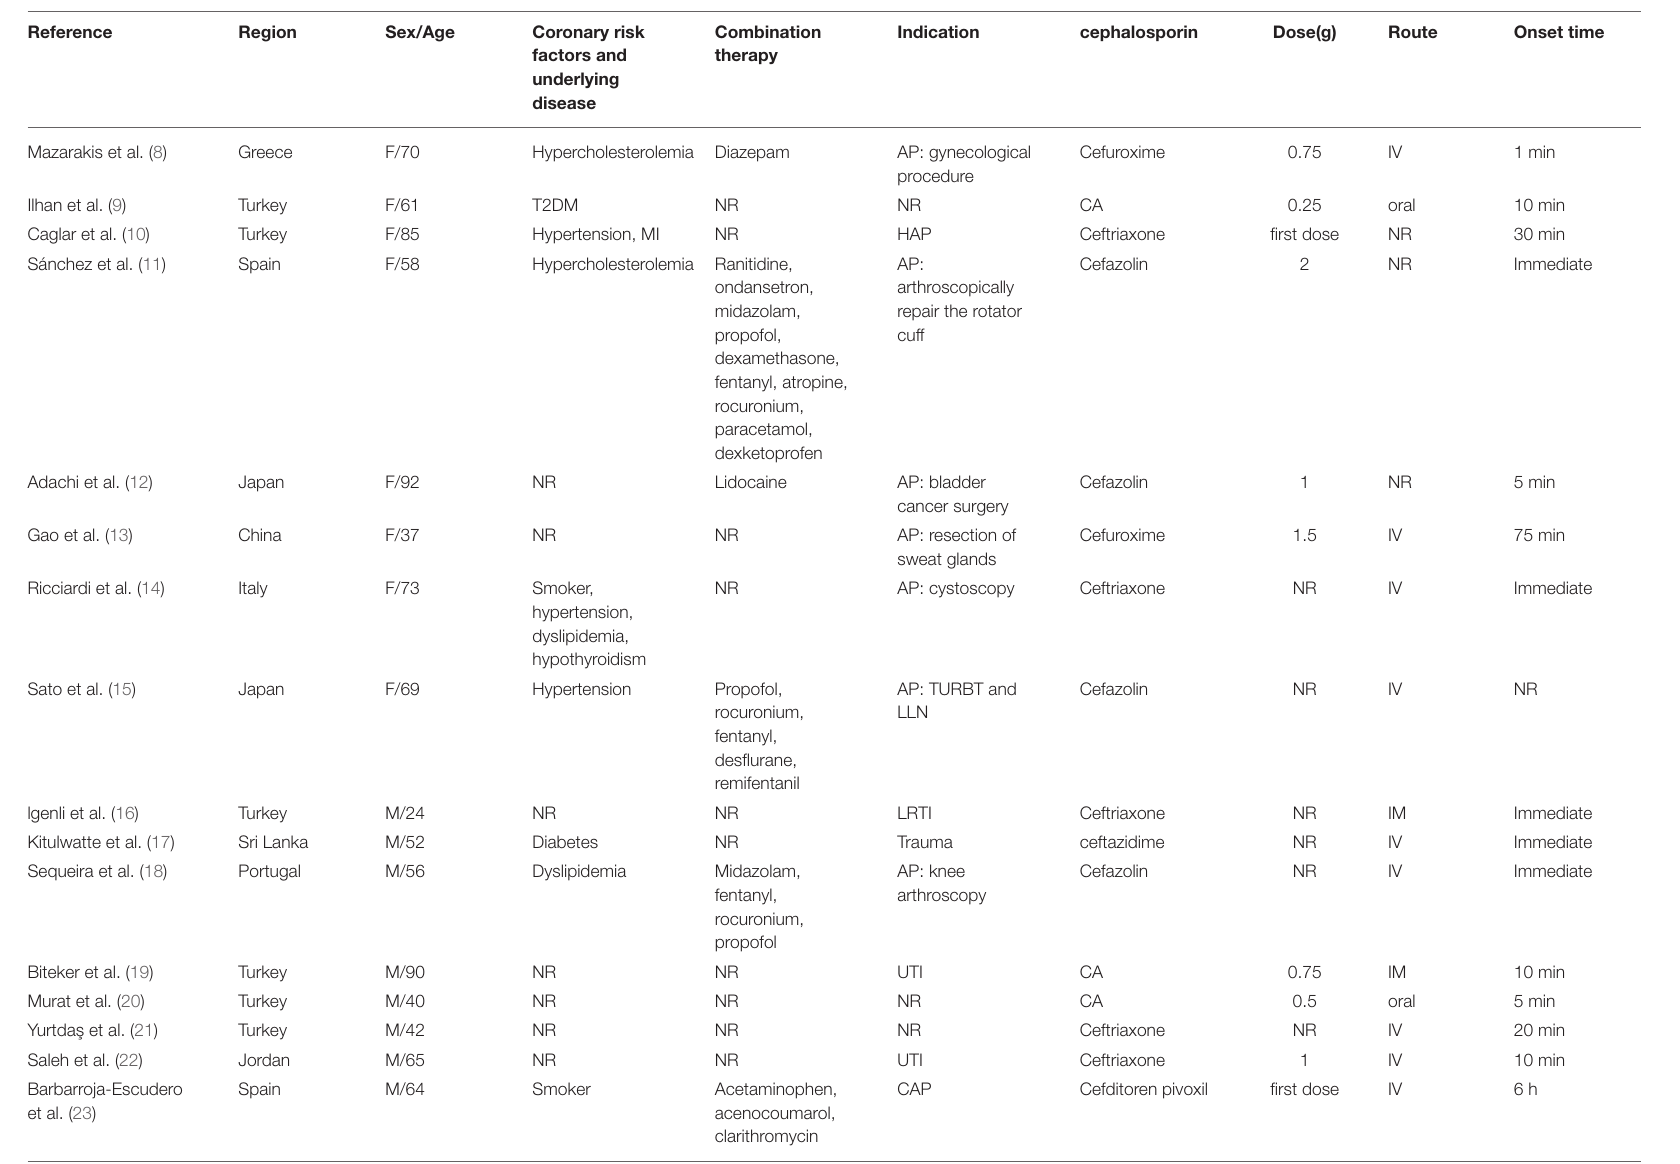
TABLE 1 | Basic information of the 25 included